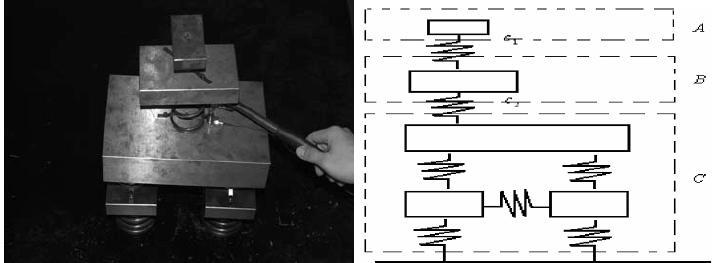
Fig. 10. Photo and model of prototype.